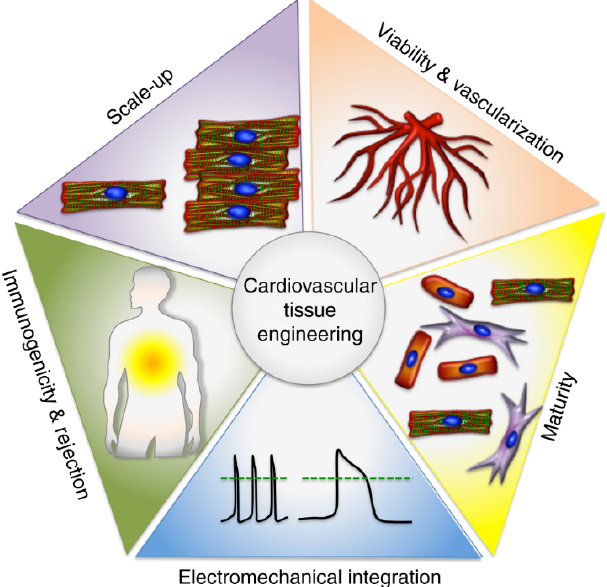
Figure 1. Cardiovascular tissue engineering